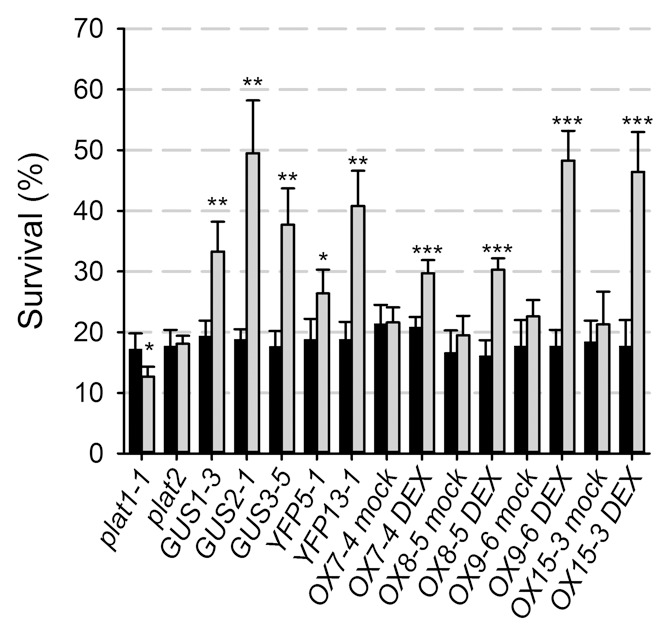
PLAT1 promotes tolerance towards salt stress conditions.Survival, expressed as the percentage of the seedlings transferred at the 6-d-old stage that developed (pale) green leaves during 4 d of salt stress conditions for the different mutant and transgenic lines (grey bars, n≥26 per replicate) compared to Col-0 control plants (black bars, n≥12 per replicate) that were grown on the same plates. Values are means of 3 replicates ± standard deviation. ***, ** or * indicate statistical significance calculated using the unpaired Student's t-test at p<0.001, p<0.01 or p<0.05, respectively.